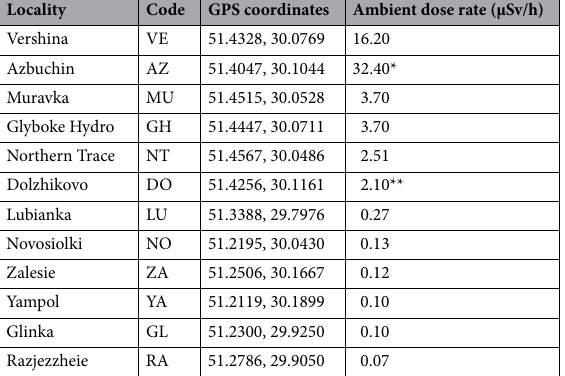
Table 1. Geographic coordinates (latitude and longitude), and current levels of environmental radiation (i.e. ambient dose rate) of the Eastern tree frog ( Hyla orientalis ) breeding localities included in the study. *7.61 µSv/h in 2017 and 2018; **1.09 µSv/h in 2017, 1.50 µSv/h in 2018, differences due to small changes in sampling areas within each locality and